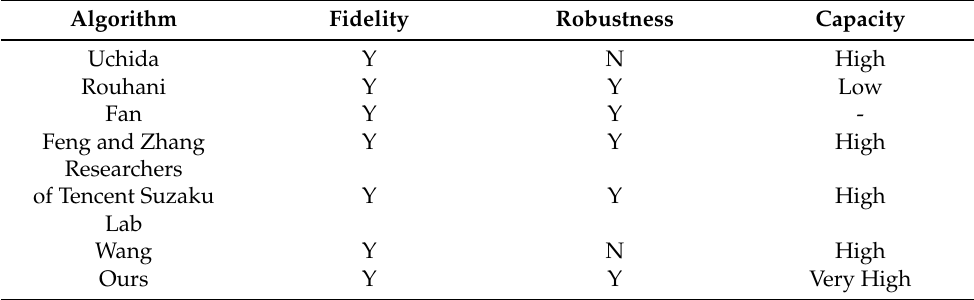
Table 8. Comparison of different algorithms (N means failed, Y means passed).